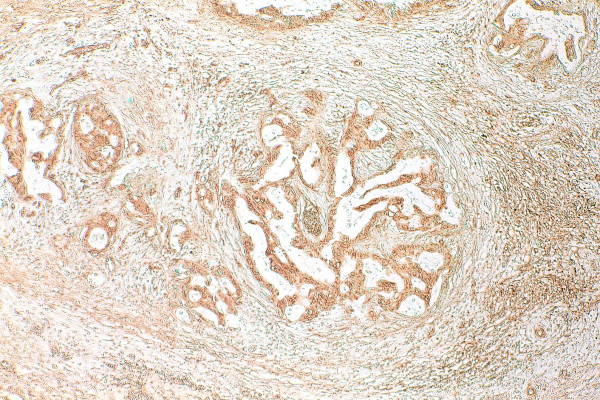
well differentiated adenocarcinoma: ILK protein was localized in both cytoplasms and nuclei. (Magnification, ×40 (Figure 1), ×16 (Figure 2), and ×40 (Figure 3)).